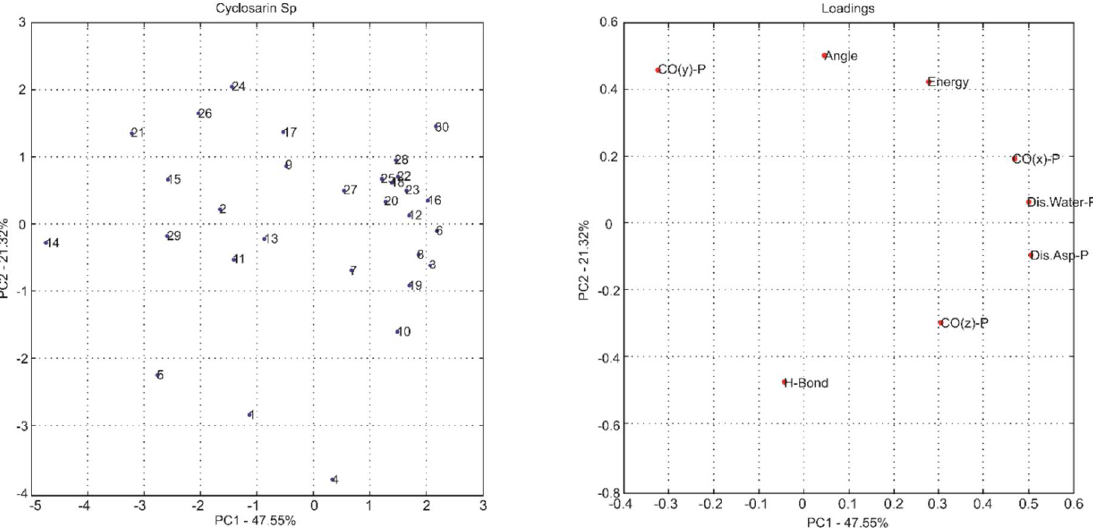
Figure 5. PC1 versus PC2 projection for Cyclosarin ( S P enantiomer) and loadings graph of the variables investigated ( left and right , respectively).